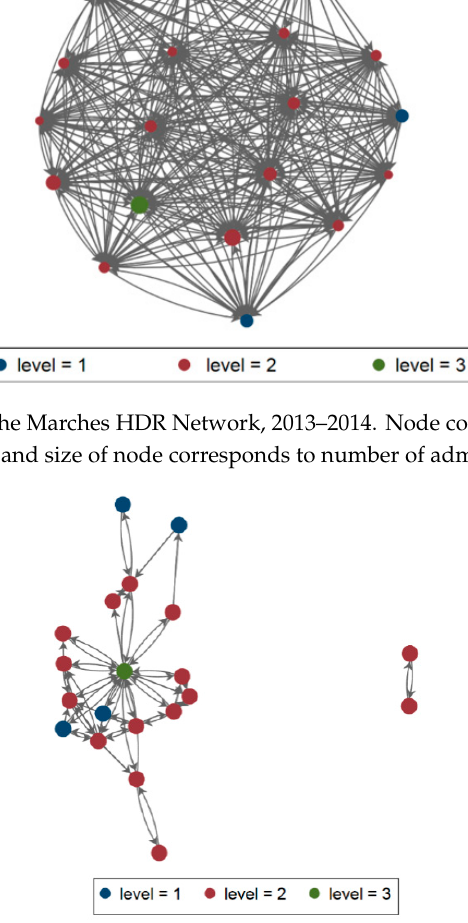
Figure 5. Visualization of the Marches MDRO network, 2013–2014. Node colour corresponds to facility type (I, II, III level of care), and size of node corresponds to number of exchanged MDROs.